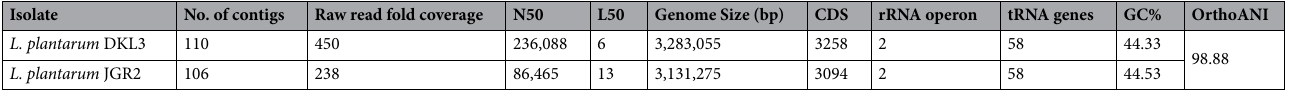
Table 1. General statistics of whole-genome sequencing of L. plantarum DKL3 and